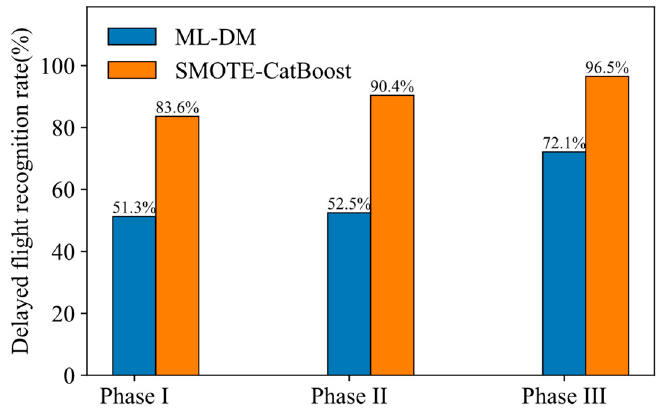
Figure 12. Delayed flight recognition rate comparison chart.